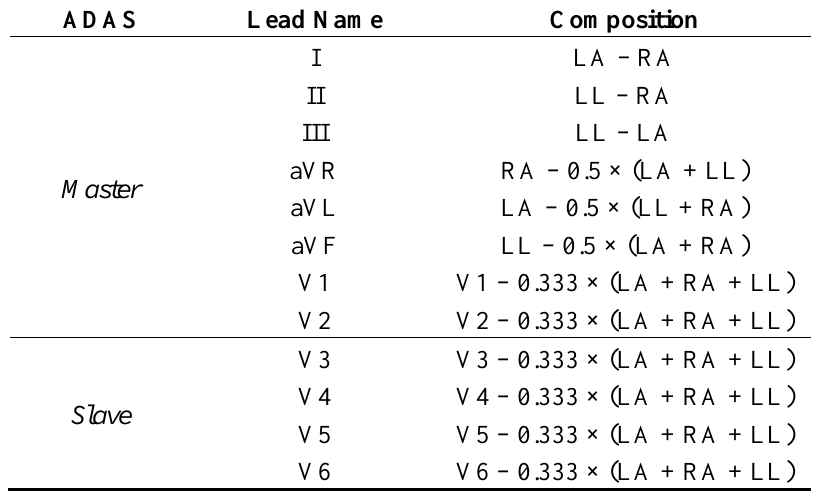
Figure 2. The ADAS1000BSTZ with LQFP64 package is depicted on the right and the one placed on the LQFP adapter (used in a first prototype with in-house manufactured PCB) is on the left. Table 1. Leads name and composition of ECG leads by using one or two ADAS